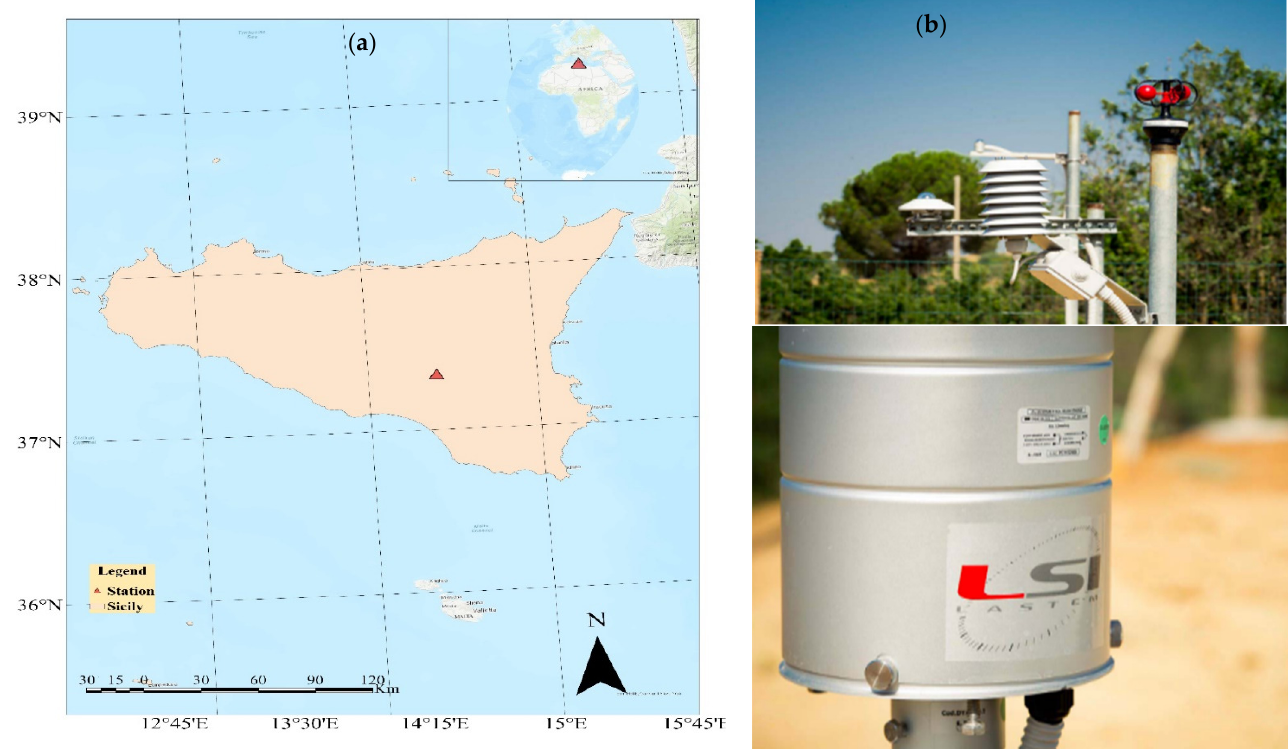
Figure 1. ( a ) Location of the experiment site and ( b ) on-site view of the meteorological station.